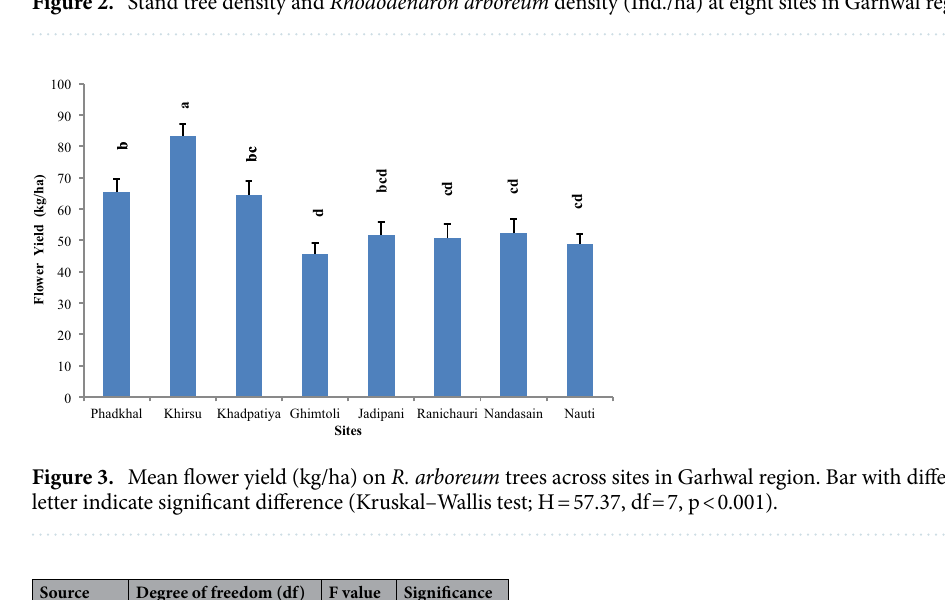
Figure 2. Stand tree density and Rhododendron arboreum density (Ind./ha) at eight sites in Garhwal region.